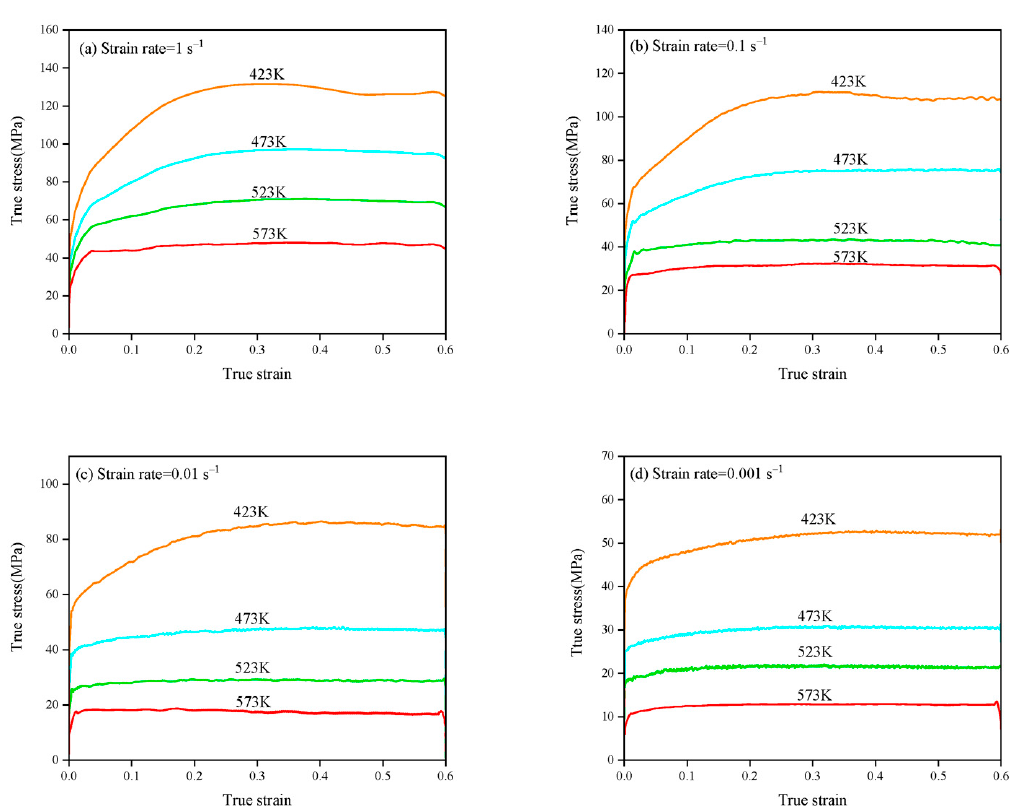
Figure 3. True stress-strain curves of Mg-6Li alloy deformed to the strain of 0.6 at different temperatures and strain rates. ( a ) strain rate = 1 s − 1 ( b ) strain rate = 0.1 s − 1 ( c ) strain rate = 0.01 s − 1 ( d ) strain rate = 0.001 s − 1